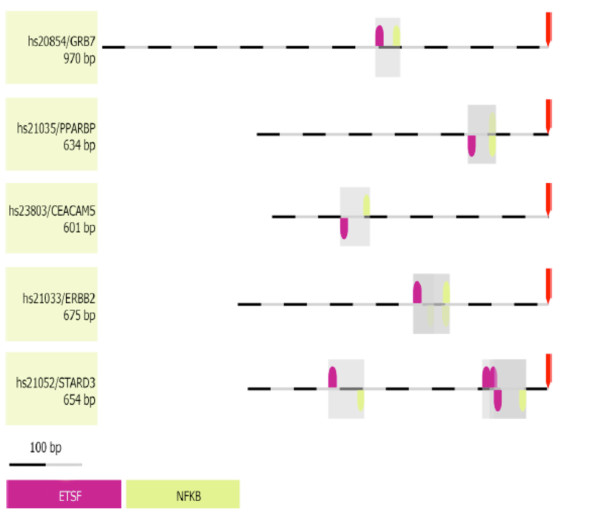
Common Framework in the ErbB2+subgroup. The common framework consisting of NF-κB and Ets found in the 6 cluster defining genes of the ErbB2+ over-expressing subgroup. Distance to next element is between 29 and 79 bp (ETSF). Directions (up/down) of the elements indicate presence of hits on sense or antisense strands respectively.